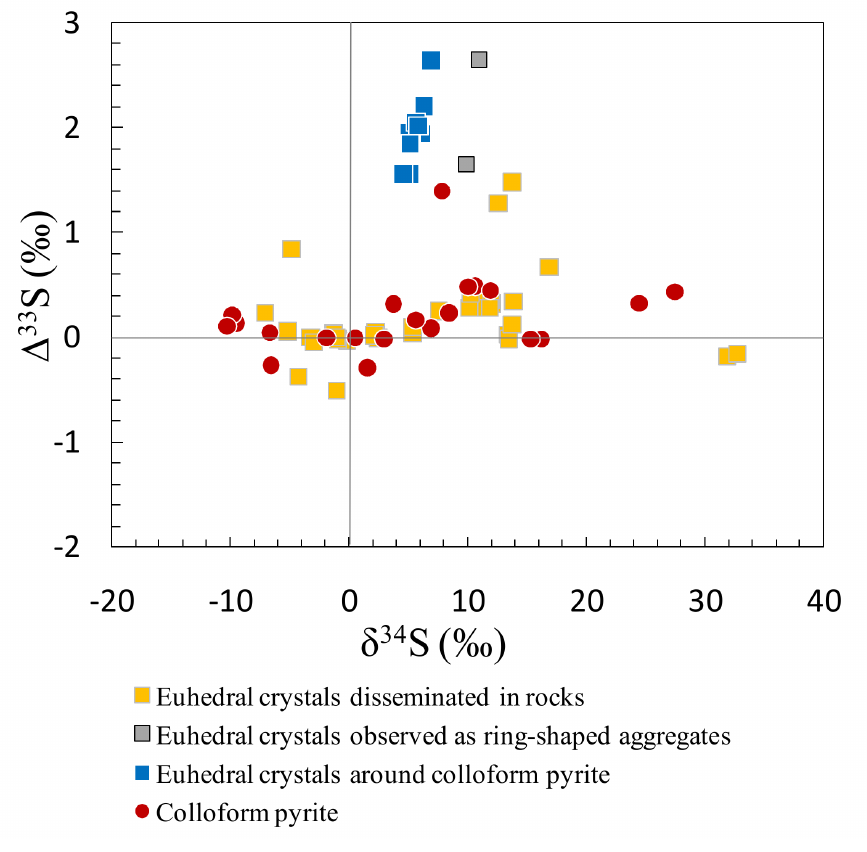
Figure 4. ∆ 33 S vs. δ 34 S values for colloform and euhedral pyrite studied here. Data from Table A1 in Appendix A. Uncertainties for the data shown are smaller than the symbol sizes for δ 34 S and ∆ 33